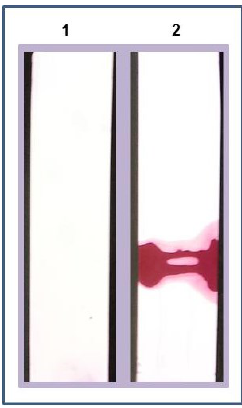
Figure 5. Detection of diabetic nephropathy marker (LPGDS): AB1 coated strips are incubated in LPGDS spiked mock urine samples. AB2 coated nanogold beads were allowed to interact with the strips. Marker detection (pointed by yellow arrows) was visualized by pink colored band (gold beads color). Strips I and II are control and strips III to VI are experimental.